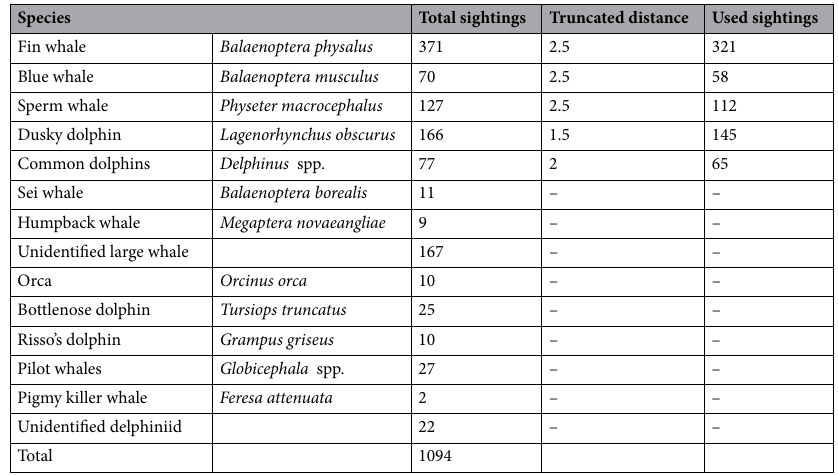
Table 2. Summary of species recorded during surveys conducted off the HCE. Common dolphins and pilot whales were identified to the genus level; hence sighting could represent either of the two species described for each genus. The truncations distance used for fitting the detection function is provided for each species with at least 30 sightings. The number of available sightings after truncation and removing data from the first five cruises is specified as used